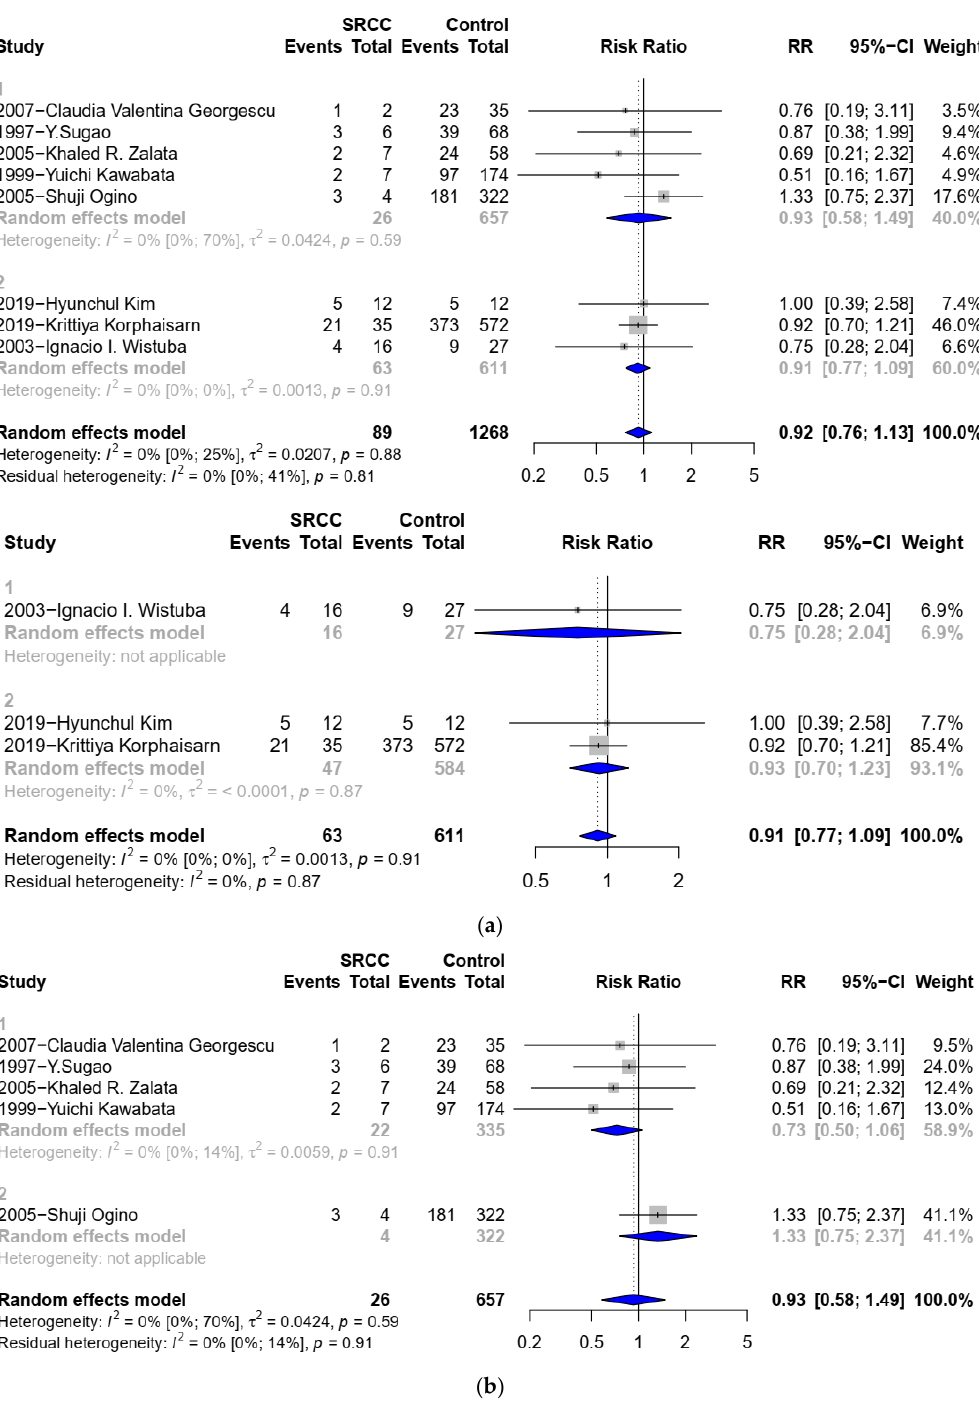
Figure 4. Forest plot for P53 status: ( 1 ). Forest plot for P53 status between SRCC and non-SRCC (using protein detection as test method). ( 2 ). Forest plot for P53 status between SRCC and non-SRCC (using gene detection as test method). ( a ) Forest plot for P53 status: ( 1 ). Forest plot for P53 status between SRCC and non-SRCC (SRC component < 50% was not excluded). ( 2 ). Forest plot for P53 status between SRCC and C-CRC. ( b ) Forest plot for P53 status: ( 1 ). Forest plot for P53 status between SRCC and non-SRCC (SRC component < 50% was not excluded). ( 2 ). Forest plot for p53 status between SRCC and